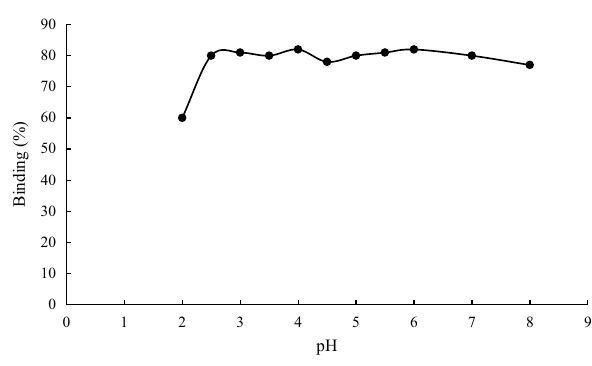
Fig. 3 Optimization of cross-linker for the preparation of ion imprint- ing polymer of